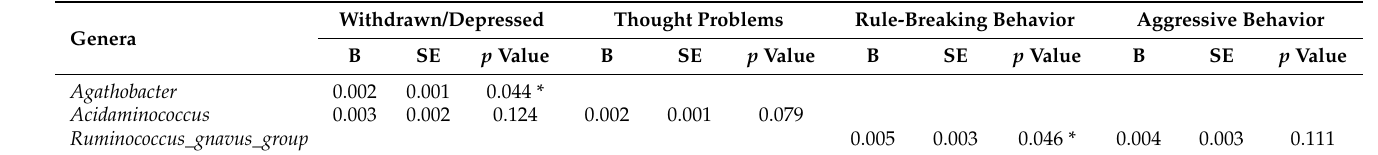
Table 4. Multiple regression analysis of the taxonomic association between gut microbiota and comor- bid emotional-behavioral symptoms of attention-deficit/hyperactivity disorder (ADHD) according to Child Behavior Checklist